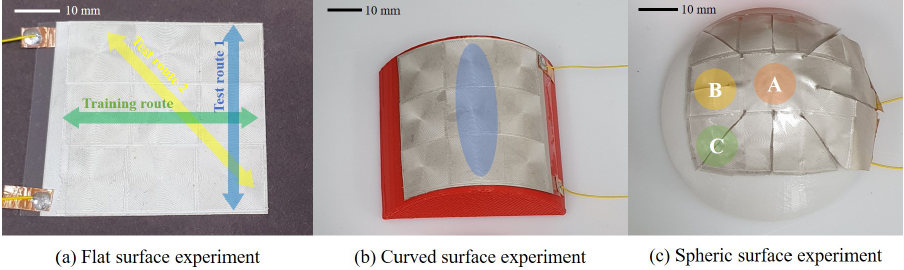
Figure 7. Contact point of each